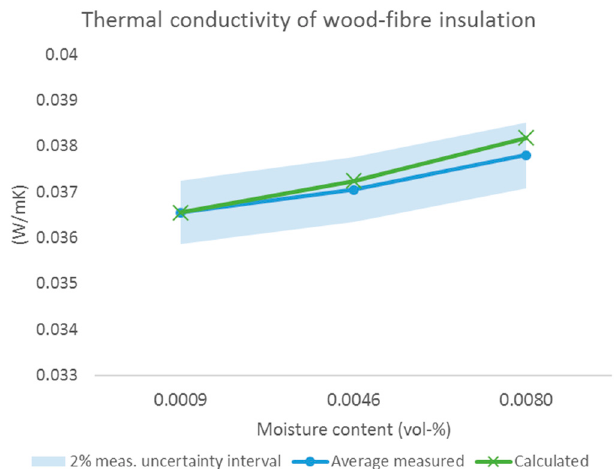
Figure 4. Measured and calculated (according to NS-EN ISO 10456) thermal conductivity of wood-fibre insulation as function of moisture content.